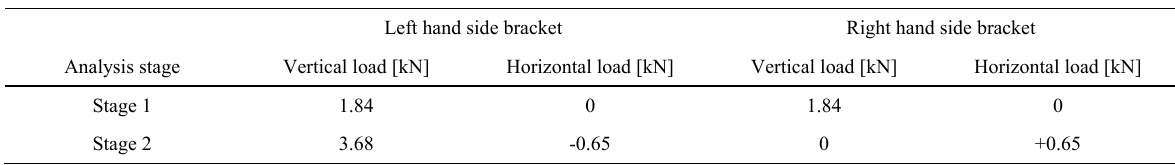
Table 5: Dead load distribution between